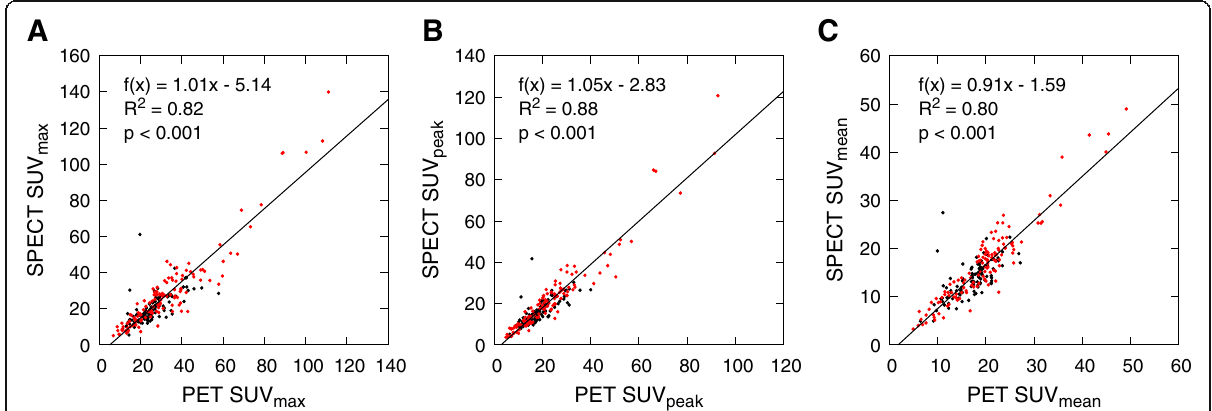
Fig. 2 Scatter plots of a SUV max , b SUV peak , and c SUV mean from SPECT and PET data for all lesions. Metastatic lesions are marked in red and benign in black. Regression lines with slopes, y -intercepts, and coefficients of determination ( R 2 ) have been calculated using the method of